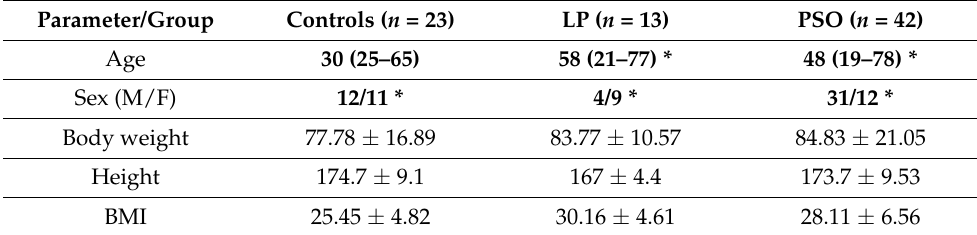
Table 1. Baseline characteristics of patients and